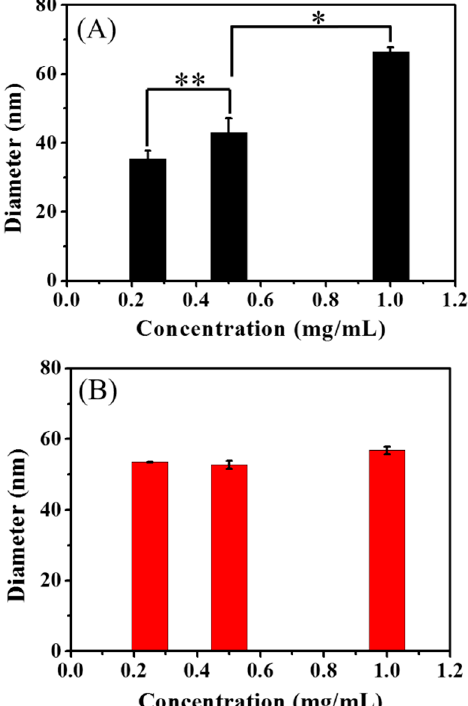
Figure 7. Average size of bb -P(HEMA- g -PNIPAAm 42 ) 50 ( A ) and cb -P(HEMA- g -PNIPAAm 42 ) 50 ( B ) at various concentrations determined by DLS at 25°C. ( p refers to the confidence coefficient; n = 10; student’s t -test, * p < 0.001, ** p < 0.05).